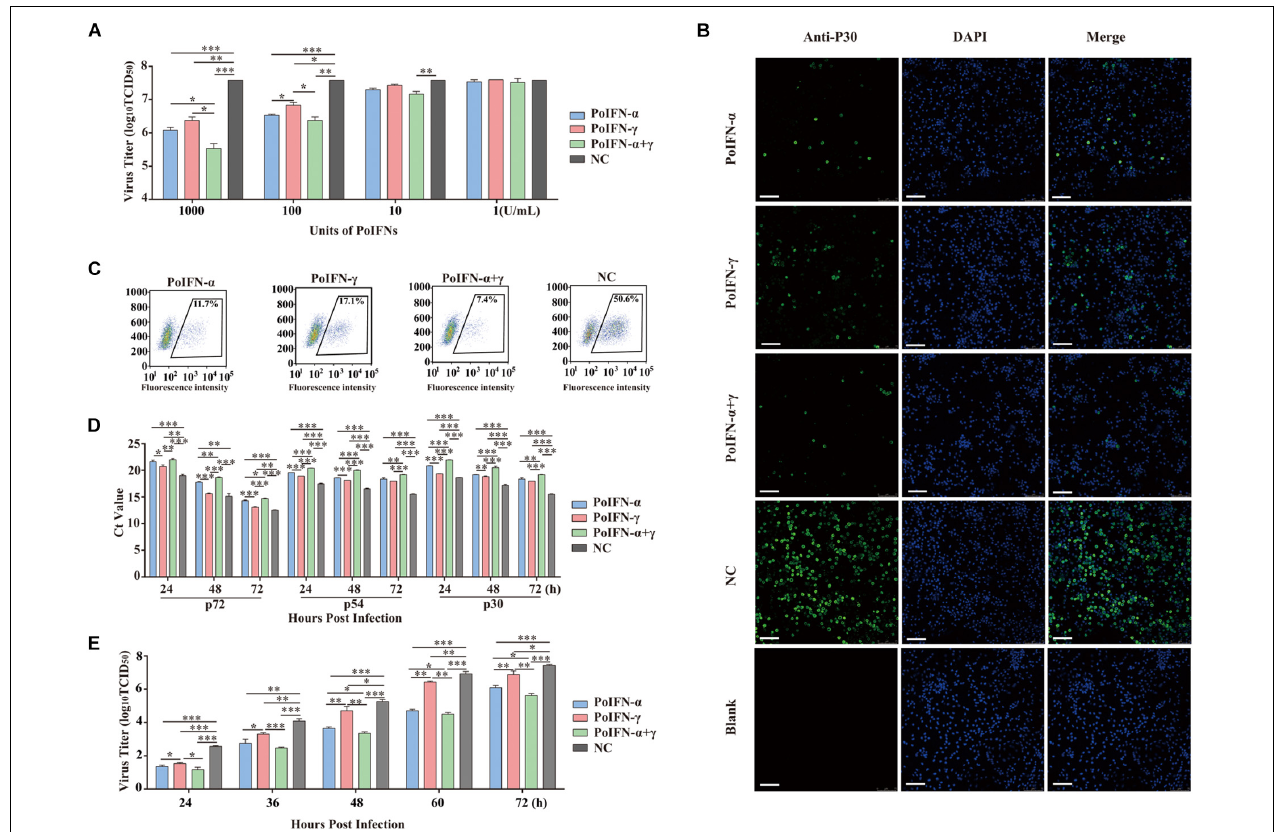
FIGURE 1 | PoIFN- α and PoIFN- γ inhibit the replication of African swine fever virus (ASFV) in primary alveolar macrophages (PAMs). (A) IFN inhibited virus replication. Primary alveolar macrophages were stimulated with PoIFN- α and PoIFN- γ at the indicated concentrations for 12 h in 24-well plates, and then the cells were infected with ASFV strain SY18 for 1 h at an MOI of 1. After removing the virus, PAMs were further cultured for 72 h prior to sample collection. (B) Indirect immunofluorescence analysis of anti-P30 expression in PAMs. The cells were exposed to a concentration of 1000 U/mL PoIFN- α , PoIFN- γ , or those combined for 12 h prior to infection with ASFV strain 18 for 1 h at an MOI of 1, maintained for 72 h after adsorption without PoIFN- α or PoIFN- γ , washed, and fixed with 4% paraformaldehyde. P30 expression was detected with a rabbit polyclonal antibody and FITC-conjugated AffiniPure Goat Anti-Rabbit IgG (H + L), and the nucleus was stained with DAPI. Scale bars represent 75 µ m. (C) The antivial of IFNs against ASFV by immunoblot analysis. The PAM cells were treated with IFNs and then were infected with SY18 and collected for indirect immunofluorescence 48 h after infection. Next step, flow cytometric were used to analyze the proportion of fluorescent cells. 10 4 cells were selected and the number of fluorescent cells was counted for the purpose of counting the proportion of fluorescent cells. (D) The effect of PoIFN- α and PoIFN- γ on ASFV replication in PAMs detected by TaqMan qPCR methods. Primary alveolar macrophages were exposed to a fixed optimal concentration of 1000 U/mL PoIFN- α , PoIFN- γ , or those combined for 12 h prior to infection with SY18 for 1 h at an MOI of 1 and maintained for different times after adsorption without PoIFN- α or PoIFN- γ ; the ASFV P72 Ct value of different groups at the indicated time points was determined. (E) Growth curve of SY18 in PAMs. Primary alveolar macrophages were exposed to a fixed optimal concentration of 1000 U/mL PoIFN- α , PoIFN- γ , or those combined for 12 h prior to infection with SY18 for 1 h at an MOI of 1 and maintained for different times after adsorption without PoIFN- α or PoIFN- γ , and the virus titer was determined in PAMs by TCID 50 assays. Three replicates were performed for all analyses. Bars represent the means ± SD ( n = 3). The data of 0 h detection point is not shown. A non-parametric test was used for the difference significance analysis. Statistically significant differences are indicated ( ∗ P < 0.05; ∗∗ P < 0.01; ∗∗∗ P < 0.001) and the line above the column marks the two groups with